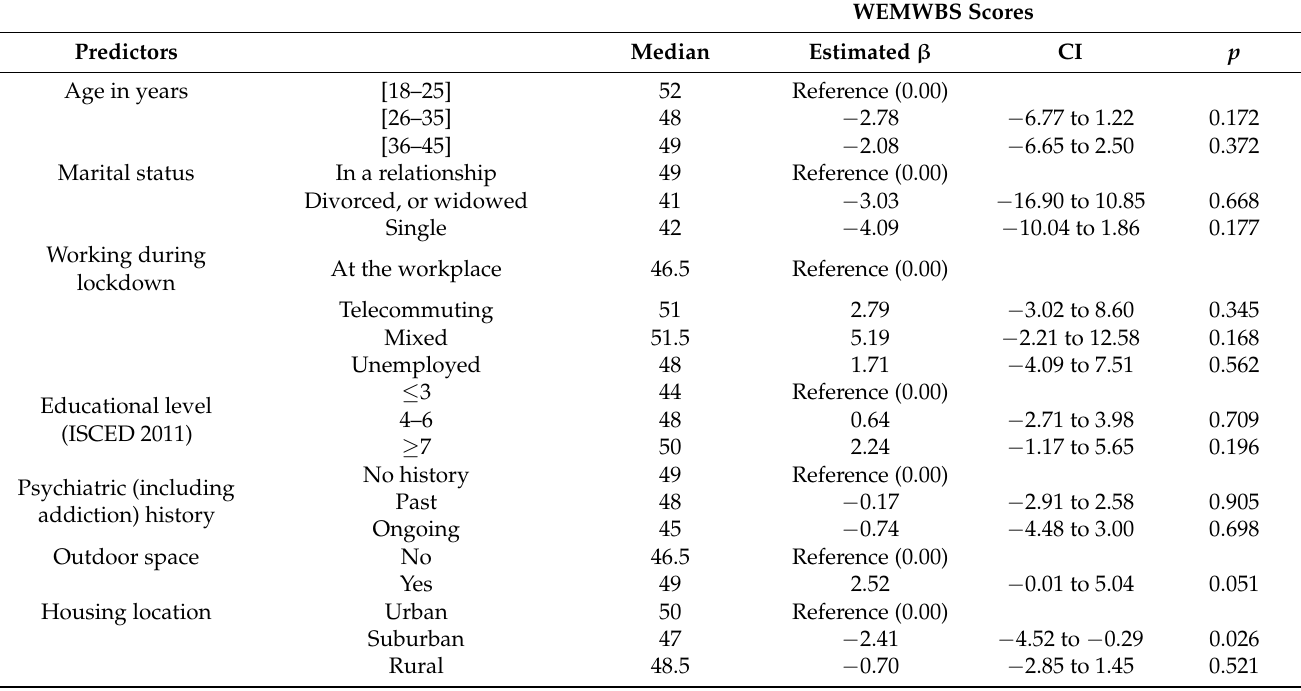
Table 2. Linear regression for total WEMWBS scores of pregnant women (n =